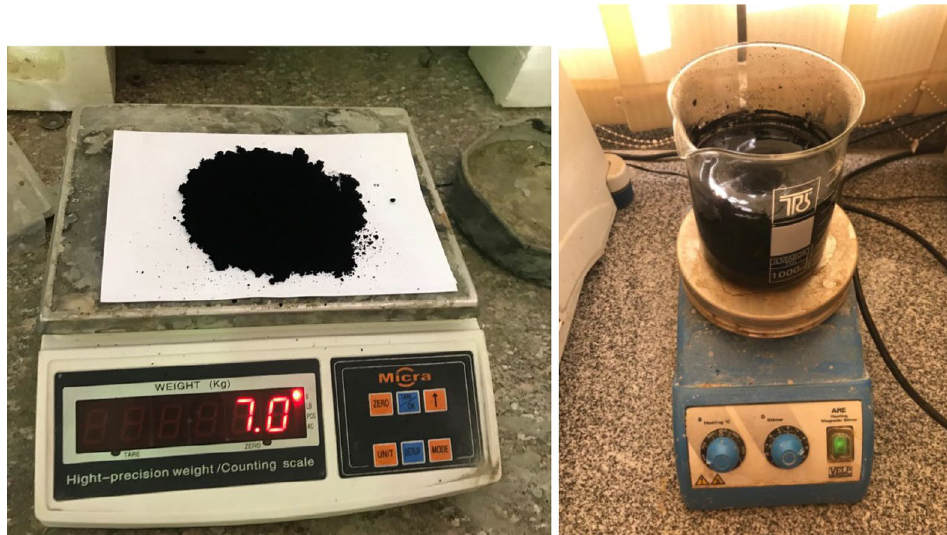
Fig. 5 CNTs powder and after mixing with water